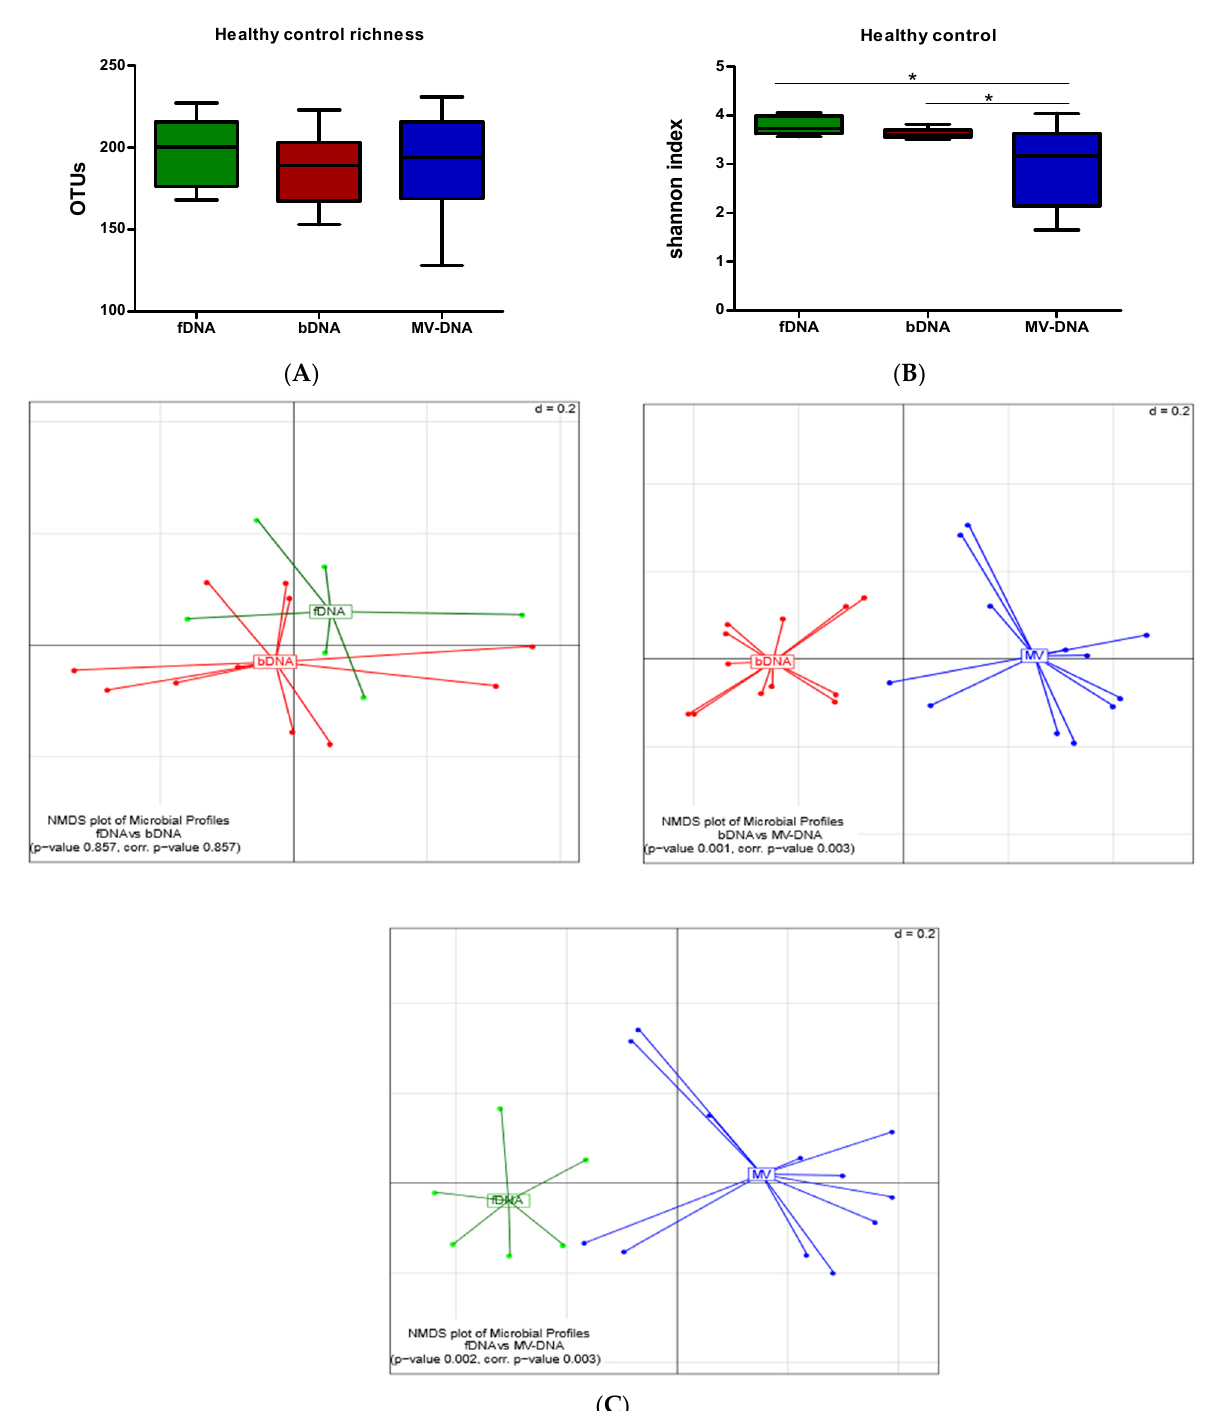
Figure 1. Microbial richness and alpha diversity of DNA obtained from HC to show the differences between the three different conditions: OTU numbers were used to represent the richness of samples. ( A ) Graphs show the richness among the three groups (fDNA, bDNA, and MV-DNA). ( B ) Shannon indices as an indicator for alpha diversity (microbial diversity within the samples). ( C ) Pairwise beta diversity of microbial compositions: non-metric multidimensional scaling (NMDS) calculated from the generalized UniFrac dissimilarity matrix (red: bDNA; green: fDNA; blue: MV-DNA). Results shown as boxplots with whiskers, and p -value indicated as * < 0.05.